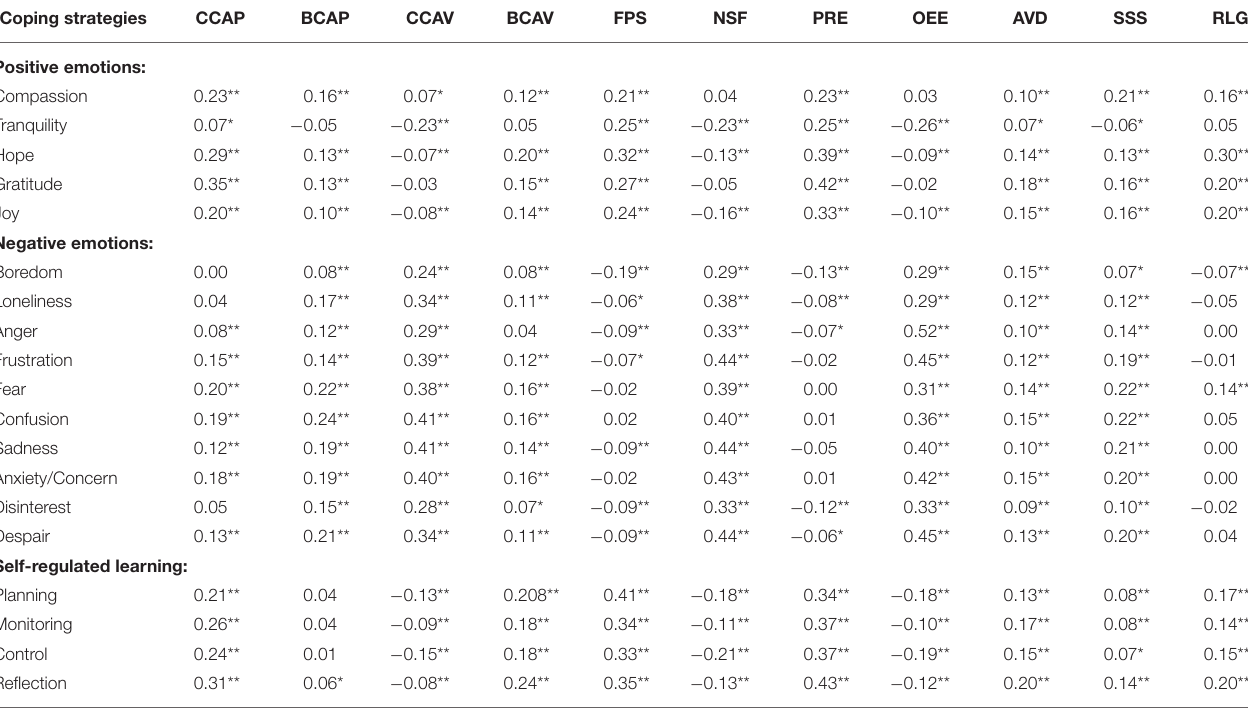
TABLE 2 | Bivariate correlations between emotions, coping strategies, and self-regulated learning ( n = 1,290). /Coping strategies CCAP